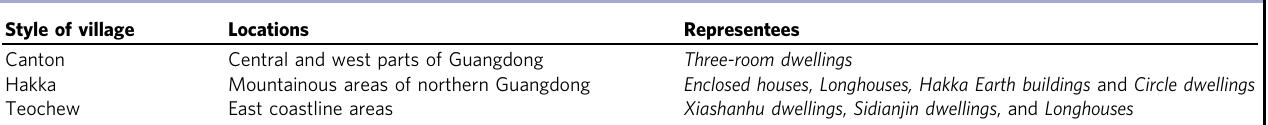
Table 1 Guangdong ’ s 3 major styles of traditional villages and their approximate location and representees in architectural